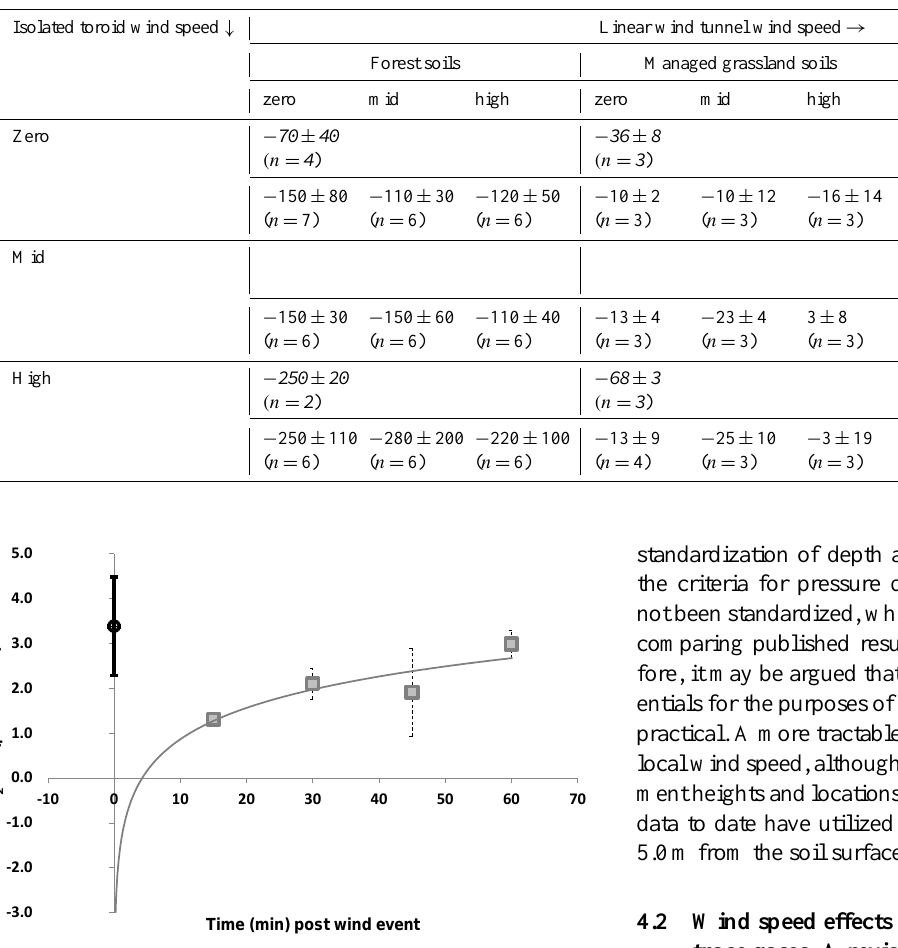
Table 3. Average CH 4 fluxes (in µg CH 4 m − 2 h − 1 ) ± standard deviation for each component of the inner toroid–outer wind tunnel matrix. Italicized, top values are for data collected in April 2011 (grassland and forest) and September 2011 (peat bog) while non-italicized bottom values indicate data collected in December and August 2011 and September 2012 for forest, grassland, and peat bog respectively. By convention positive values indicate efflux of CH 4 from the soil surface into the atmosphere.